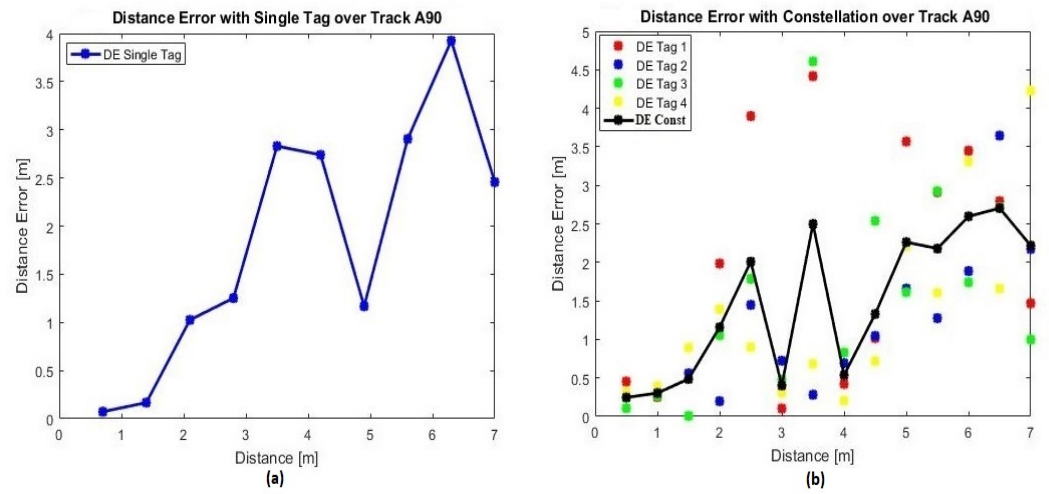
Figure 11. Estimated distance errors for single tag and constellation of tags scenarios over track A90.